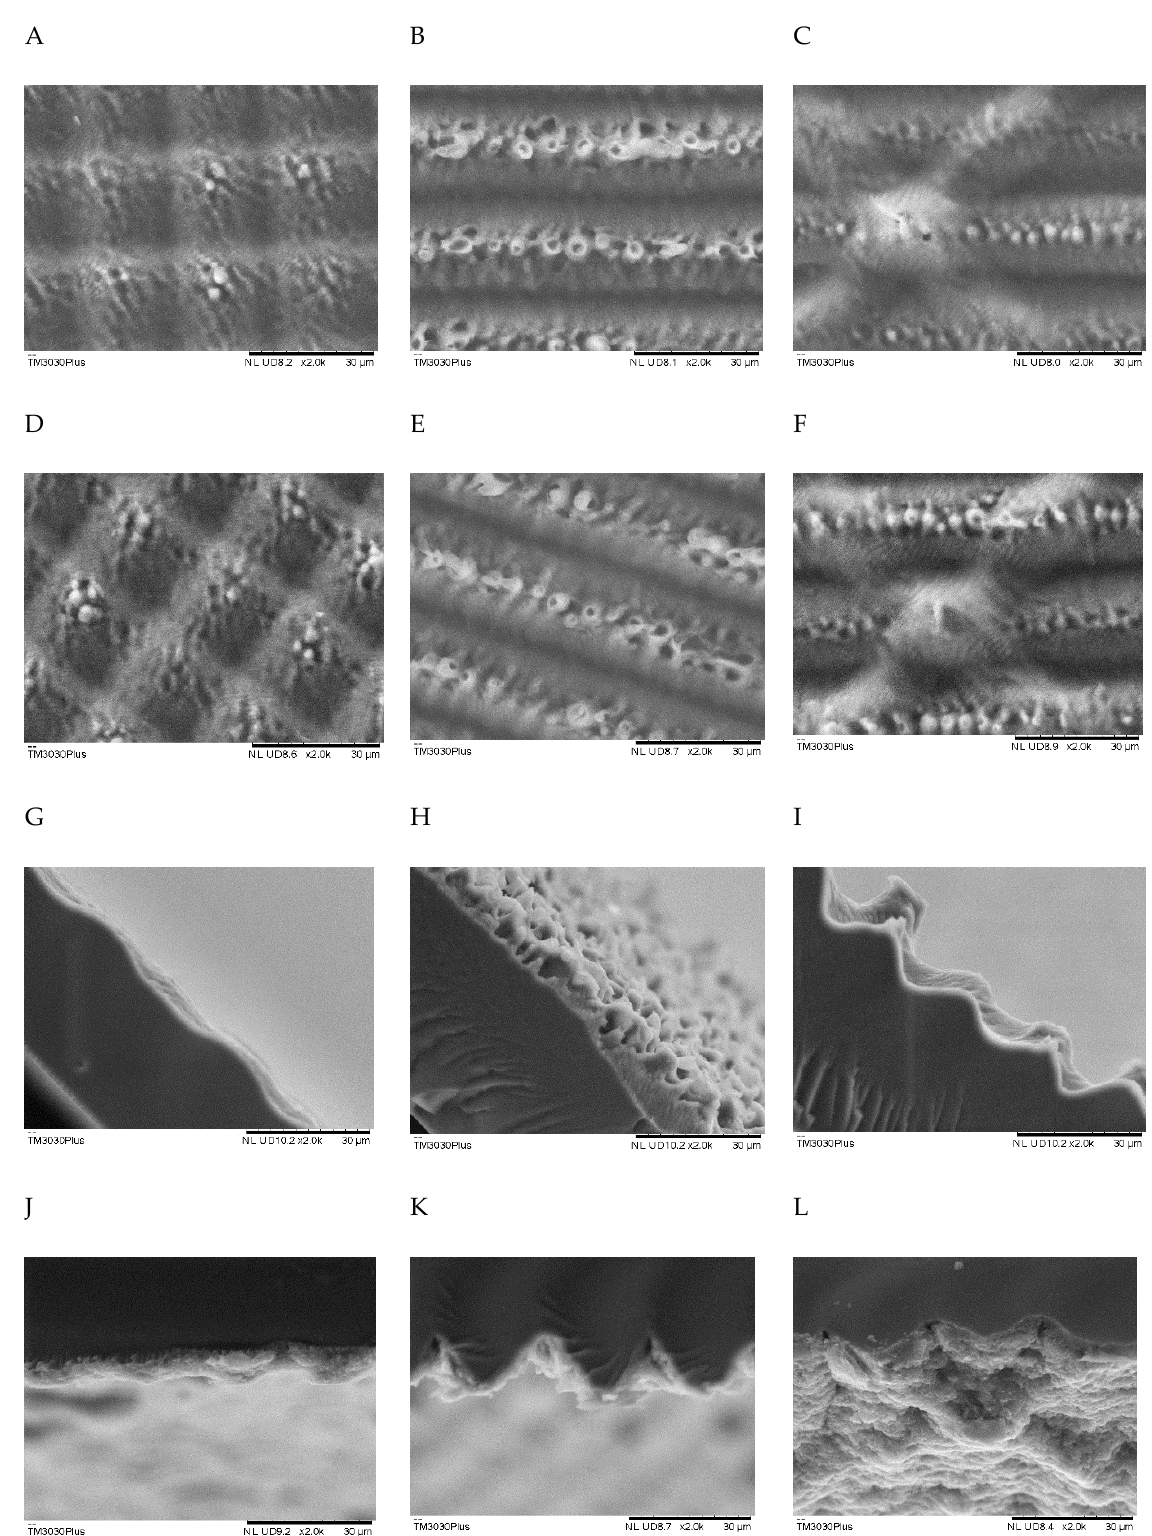
Figure 1. SEM images of the patterned membranes at different fabrication stages; ( A – C ) freshly cast, ( D – F ) post-activation, ( G – I ) cross-section after activation, ( J – L ) cross-section after catalyst layer is applied. Lotus pattern ( A , D , G , J ). Lines pattern ( B , E , H , K ). Sharklet pattern ( C , F , I , L ).